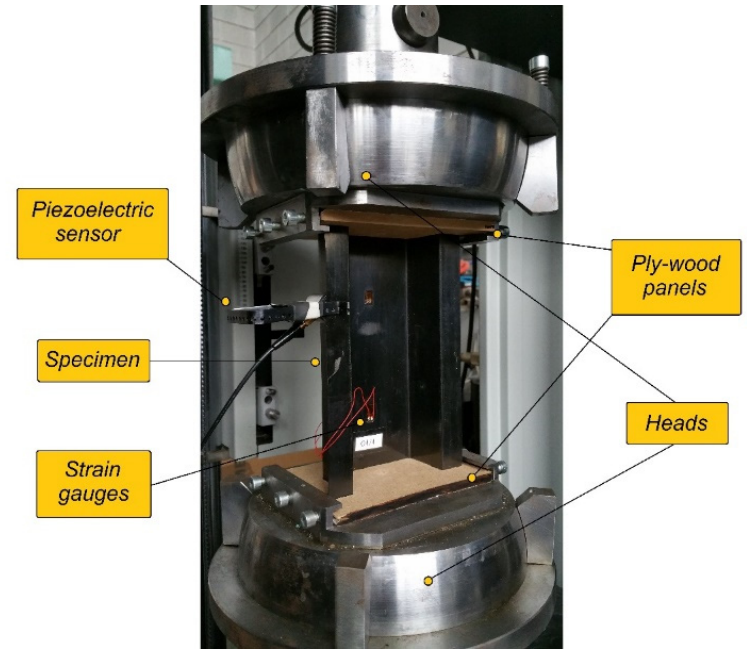
Figure 2. Experimental stand.